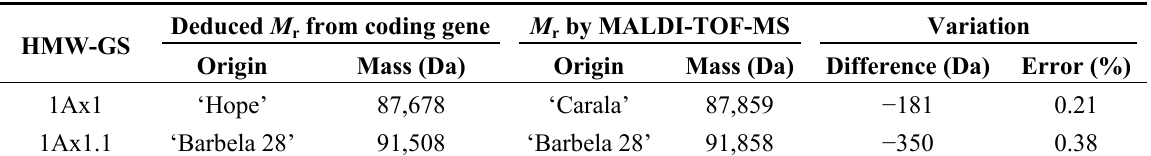
Table 1. Comparison of HMW-GS molecular masses deduced from coding gene sequences with those determined by